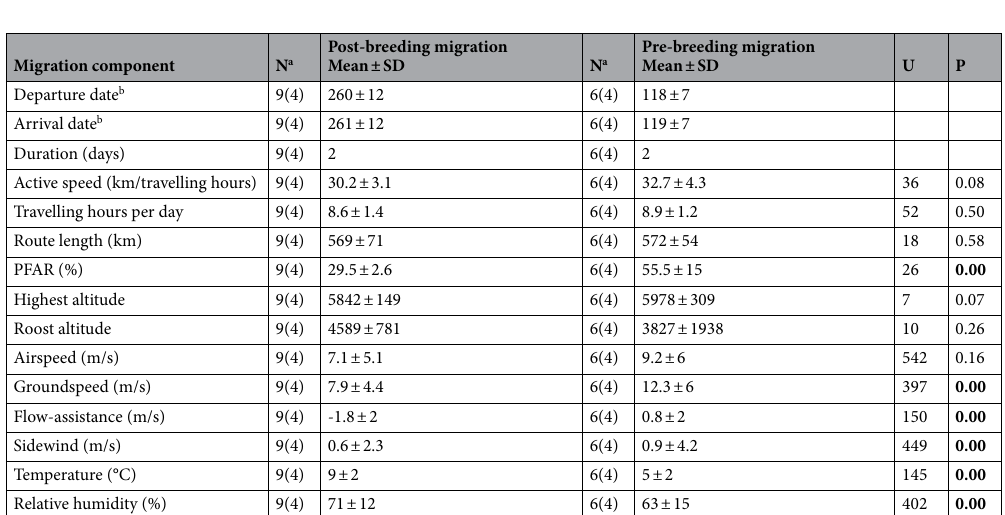
Table 6. Estimates of post and pre-breeding migration over the Himalayas by tagged Black Kites during 2019 and 2021. a Number of migration episodes (number of tagged individuals). b Julian date (1 = 1 January). Departure date—first day with coordinates recorded in altitude over 5000 m above the sea level, Arrival date—last day with coordinates recorded in altitude over 5000 m above the sea level, Airspeed—speed of a bird relative to the air. Groundspeed—speed of bird relative to the earth. PFAR—percentage of parallel flight along the mountain ridge. Only birds K14–K19 were included in the table due to high frequency of data collection. Birds that died before or during migration were omitted from the test. Differences in mean values were tested by Mann–Whitney U test for nonparametric data and significant results are highlighted in